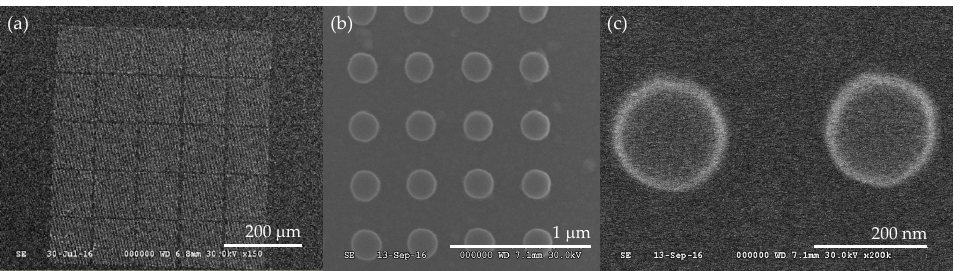
Figure 3. Planar view SEM images of a Co/Ag nanodot array at ( a ) 150 × , ( b ) 50,000 × , and ( c ) 200,000 × magnification.